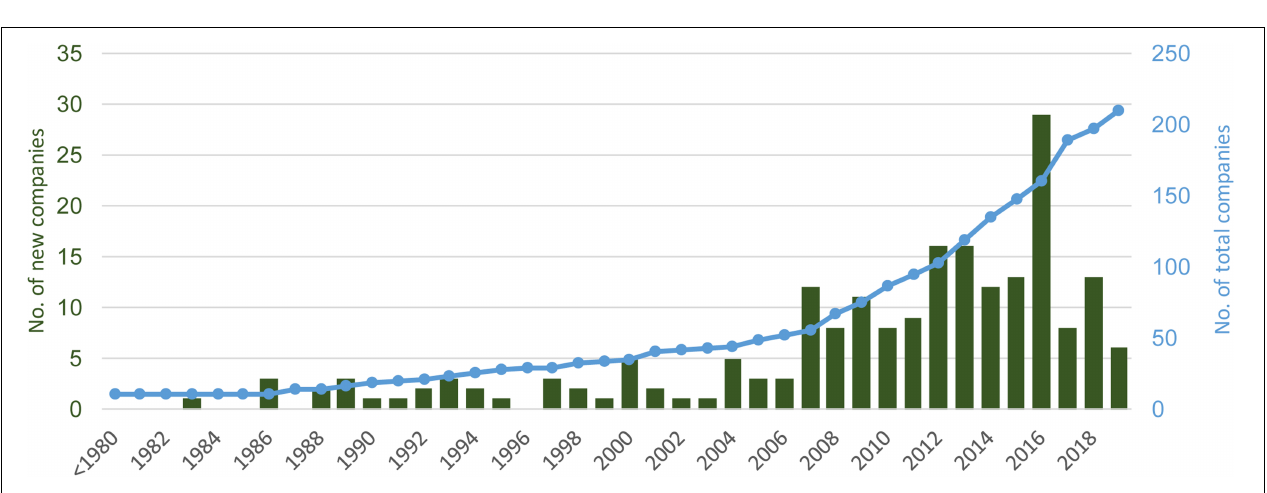
FIGURE 4 | Numbers of macro- and microalgae producing companies in Europe broken down by production technology and country.